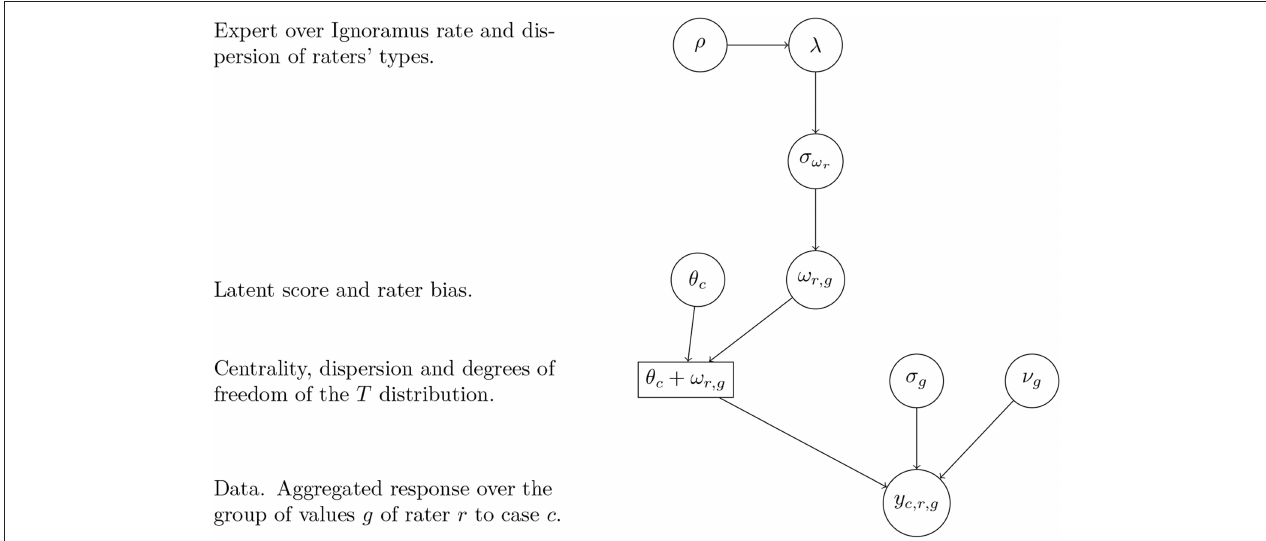
FIGURE 3 | Directed Acyclic Graph of the connections between the parameters to estimate and the data ( y c , r , g ).